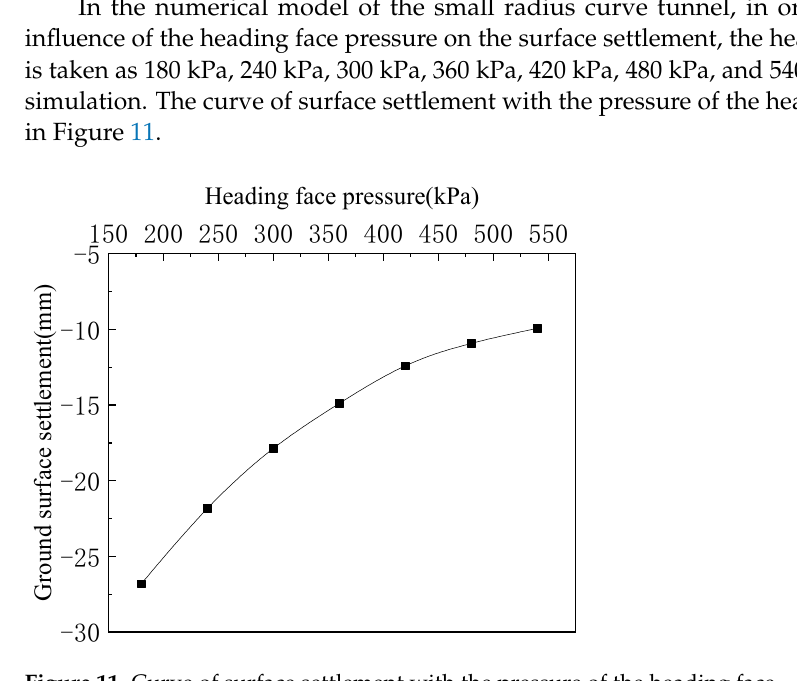
Figure 11. Curve of surface settlement with the pressure of the heading face.